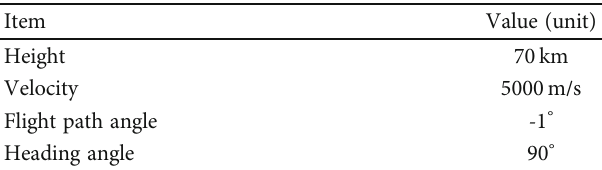
Table 1: Nominal states.